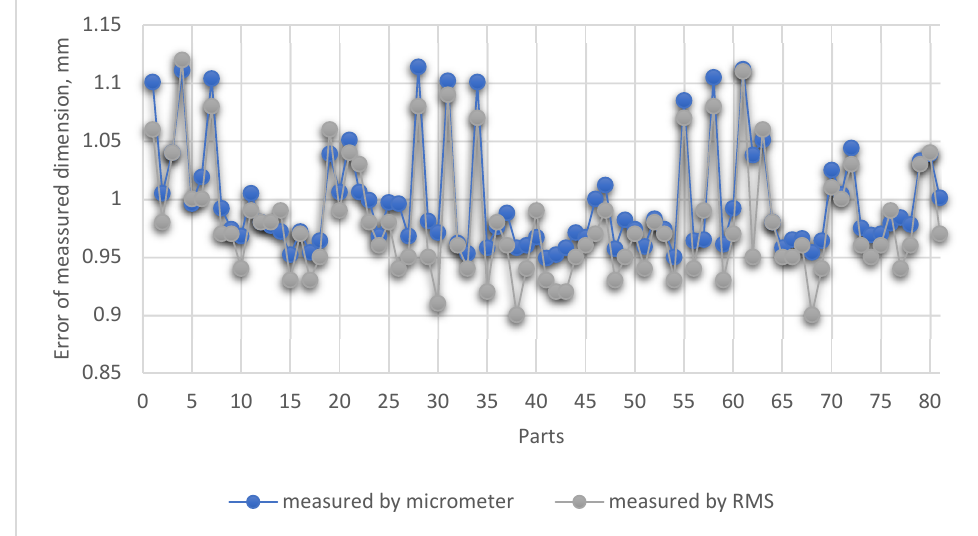
Figure 7. Micrometer and RMS measurement results comparison.